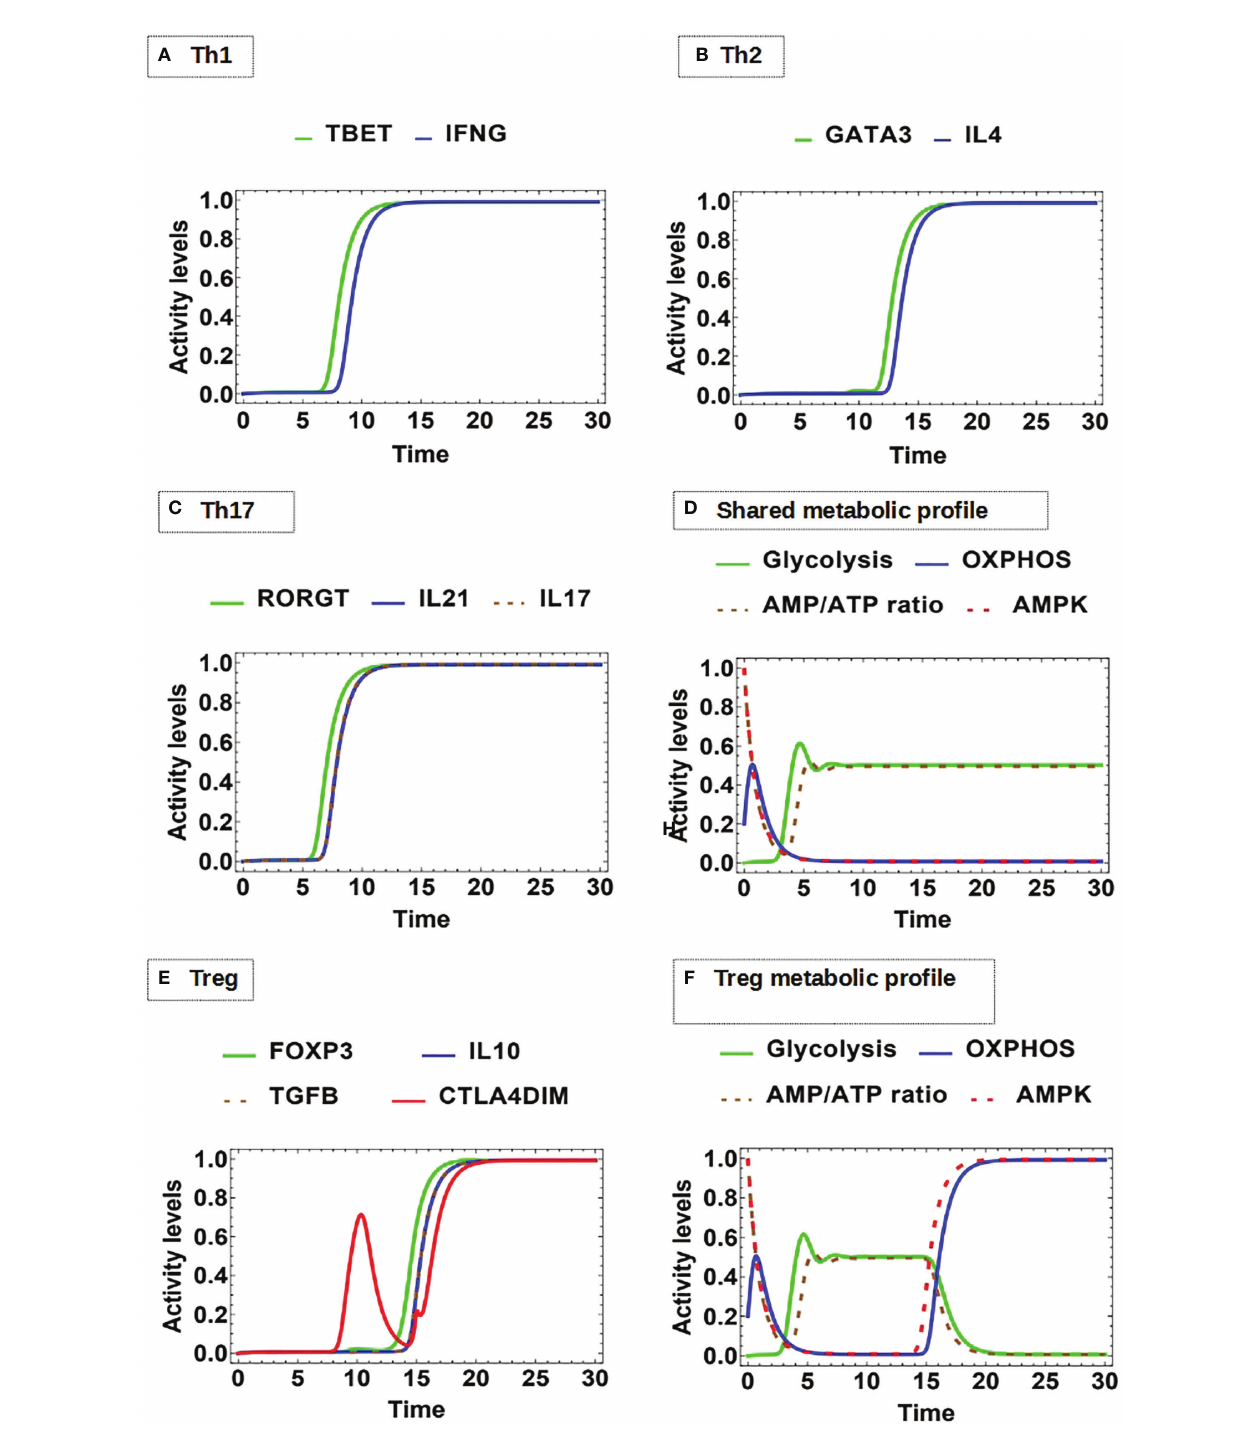
FIGURE 7 | Dynamics of master transcription factors and interleukin production by effector cells under optimal antigenic recognition and low-level activity of CTLA-4: (A) Th1 pro fi le: Sustained expression of T-bet and INF-gamma production, (B) Th2 pro fi le: Sustained expression of GATA3 and IL-4 production, (C) Th17 pro fi le: Sustained expression of ROR g T, as well as Il-17 and IL-21 production. (D) The Th1, Th2, and Th17 phenotypes display an initial transient OXPHOS phase and then a stable glycolytic metabolism. (E) Treg pro fi le: Sustained expression of Foxp3 and dimeric CTLA-4 with joint production of IL-10 and TGF- b . (F) Treg displays an initial transient OXPHOS phase followed by glycolytic metabolism; however, with the course of time this is replaced by a metabolism based on